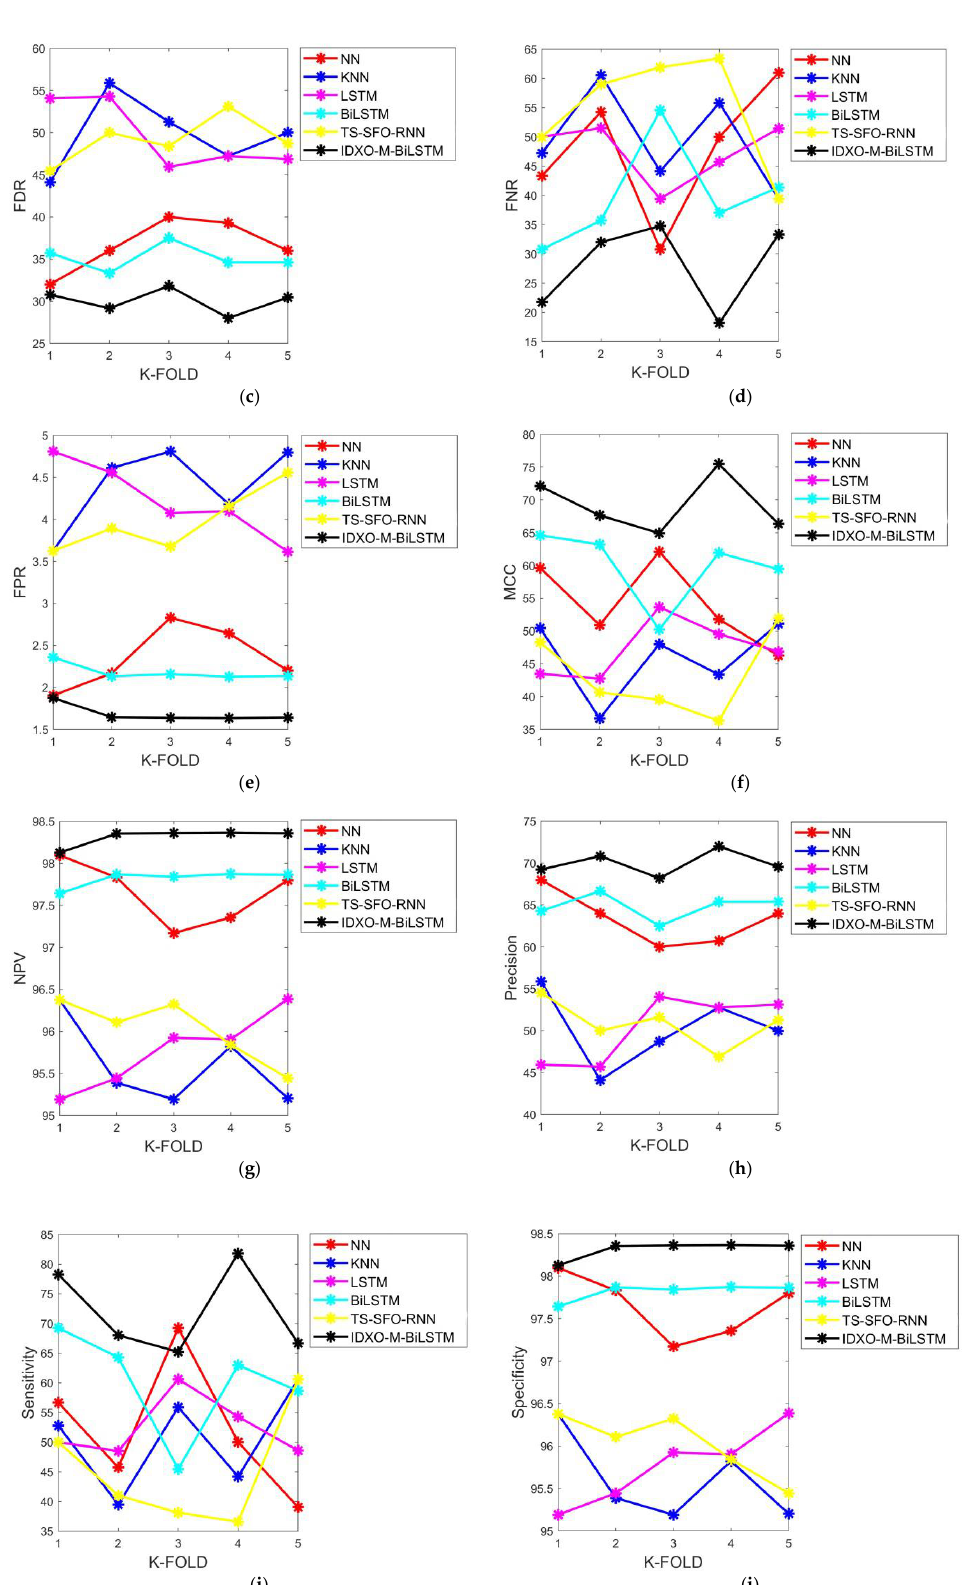
Figure 5. K-fold analysis of the suggested prediction of heart disease model with existing prediction algorithms (NN [49], KNN [50], LSTM [51], BiLSTM [52], TS-SFO-RNN [48]) over ( a ) accuracy, ( b ) F1-score, ( c ) FDR, ( d ) FNR, ( e ) FPR, ( f ) MCC, ( g ) NPV, ( h ) precision, ( i ) sensitivity and ( j ) specificity Analysis of the developed model in WBAN with heuristic approaches. Validation of the offered heart disease identification model based on WBAN with heuristic approaches is displayed in Figure 6. The efficacy analysis performed on initiated heart disease detection model attained an accurate prediction rate than baseline ap- proaches like GWO-M-BiLSTM, DA-M-BiLSTM, DOX-M-BiLSTM, SFO-TSA-M-BiLSTM, and TS-SFO-RNN as 9.71%, 5.26%, 4.0%, 4.3%, and 4.46%, respectively in the learning per- centage of 70. The developed model attained an effective high detection rate in accuracy analysis than the conventional approaches. Here, the accuracy rate of the designed method is improved to the 85 th learning percentage. The TS-SFO algorithm attains a sec- ond better performance. GWO is the least algorithm. Due to this, it has not the ability to resolve optimization problems. Accordingly, the MCC of the designed method improves at the 85th learning percentage. While taking the FDR rate, it decreases the errors at the 85th learning percentage. Therefore, it is revealed that the better performance of the given designed method attains the 85th learning percentage. Thus the developed model based on WBAN archived a more efficient heart disease identification rate than the existing mod- els. ( a )